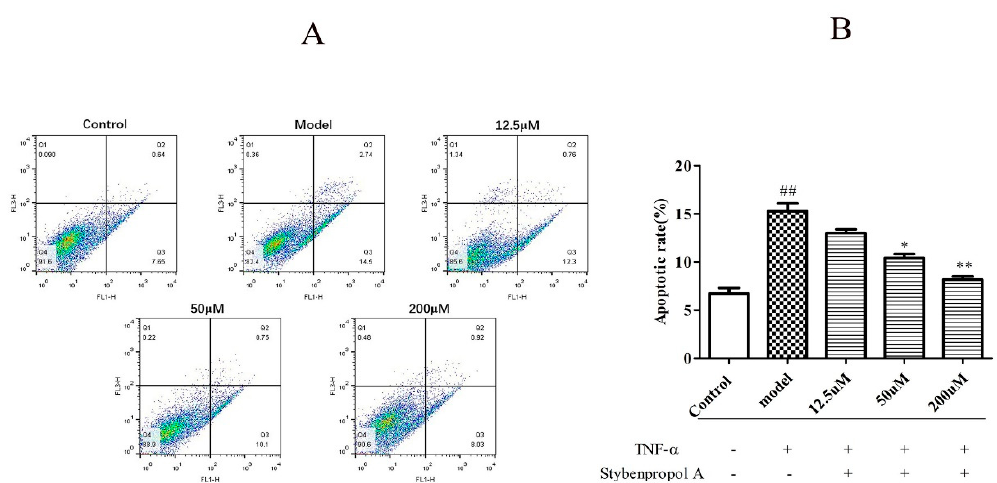
Figure 6. Stybenpropol A inhibited HUVEC apoptosis induced by TNF- α . Following a 24 h pretreatment with stybenpropol A (12.5, 50, 200 µ M), HUVECs were treated with TNF- α and annexin V / PI staining was used to assess apoptosis ( A ). Quantification of apoptosis rates ( B ). Data are means ± SD of three independent experiments. ## p < 0.01 vs. control; ∗ p < 0.05, ∗∗ p < 0.01 vs. model group.